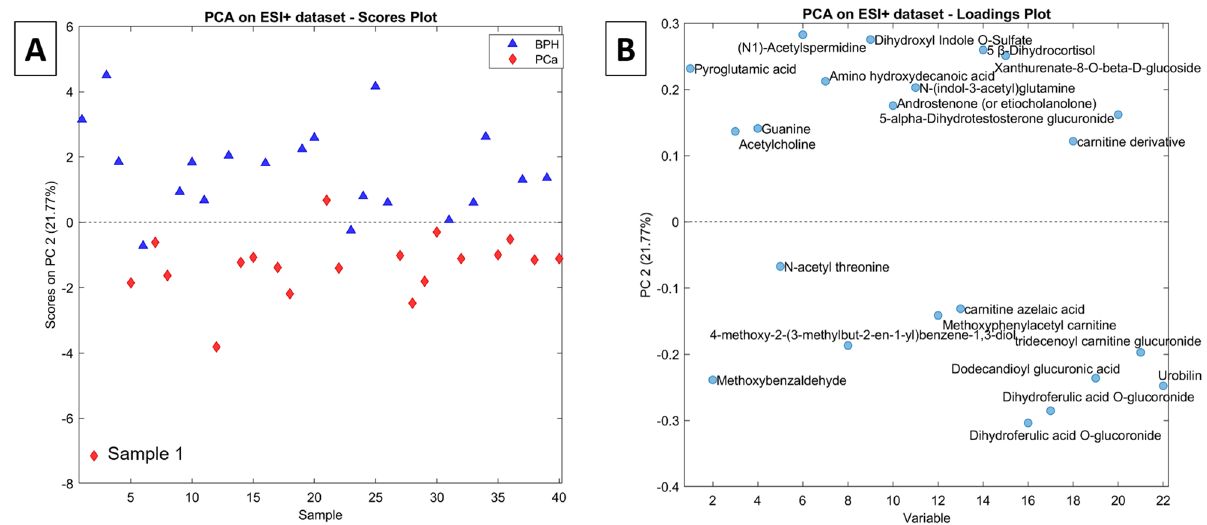
Figure 1. ( A ) scores plot and ( B ) loadings plot of the PCA model for the autoscaled ESI +